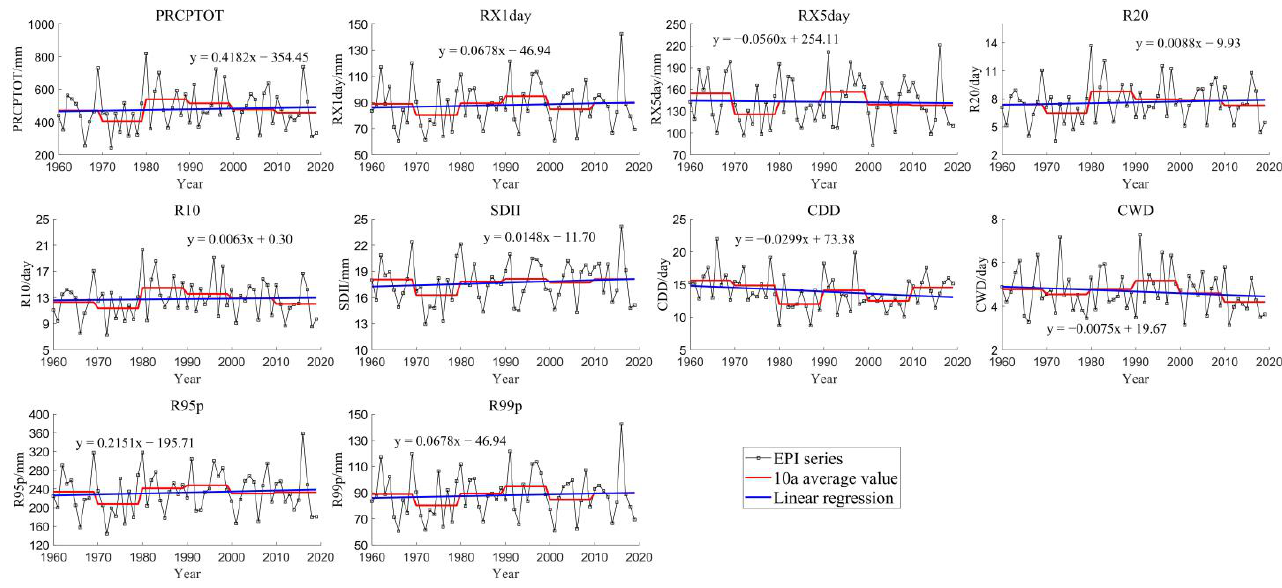
Figure 6. Trend and 10a average value of EPIs within Hubei province in summer during 1960 – 2019. Table 5. Statistic of change trend of each EPI within Hubei province in summer during